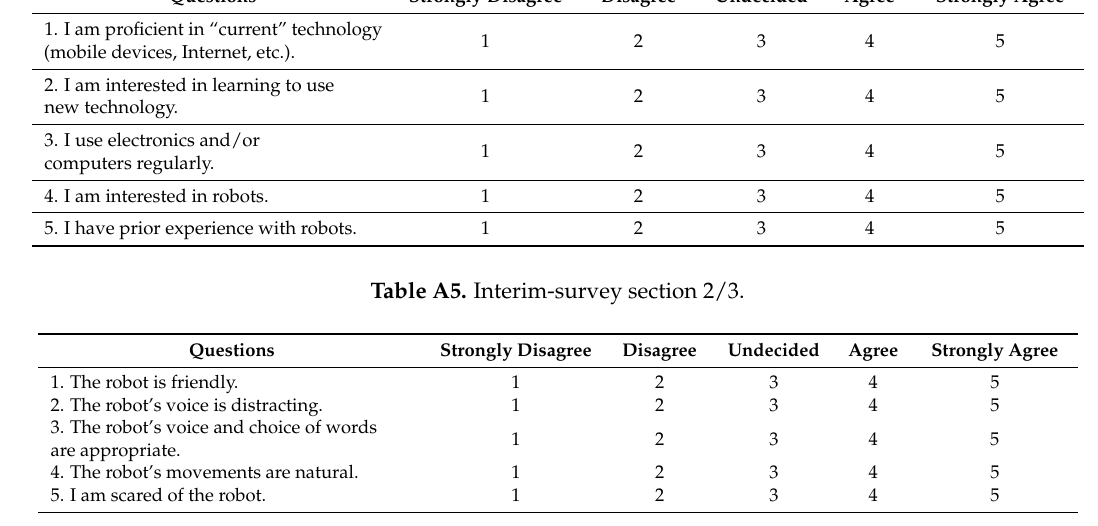
Table A6. Interim-survey section 3/3.